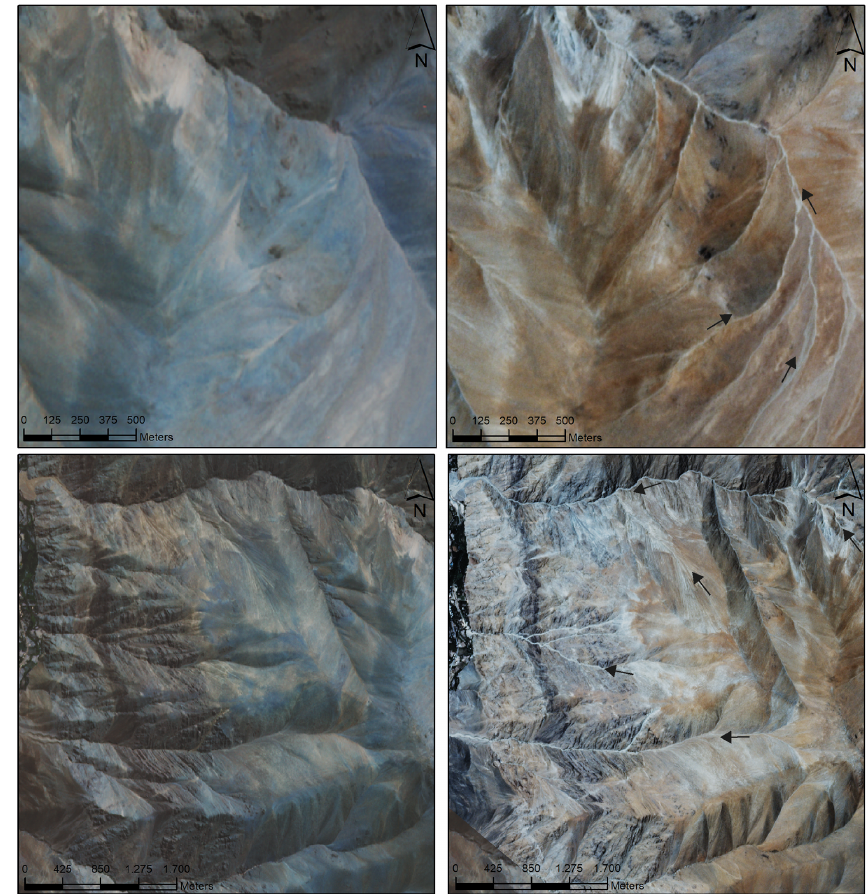
Figure 4. Optical imagery retrieved from Planet Team (2017) before and after March 2015 storm. Left-hand images are before the March 2015 storm and right-hand images are after. Arrows indicate different physical evidence of erosion processes due to the event and gully presence after March 2015 storm. The general color tone change merely indicates different sun